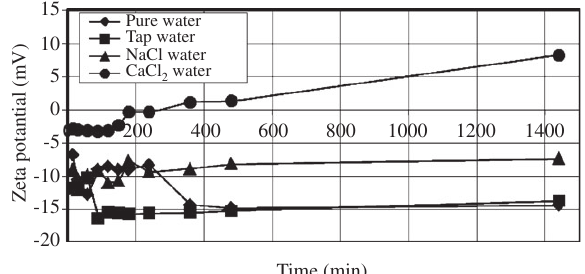
Figure 4 Time-dependent zeta potential variation of cement sus-